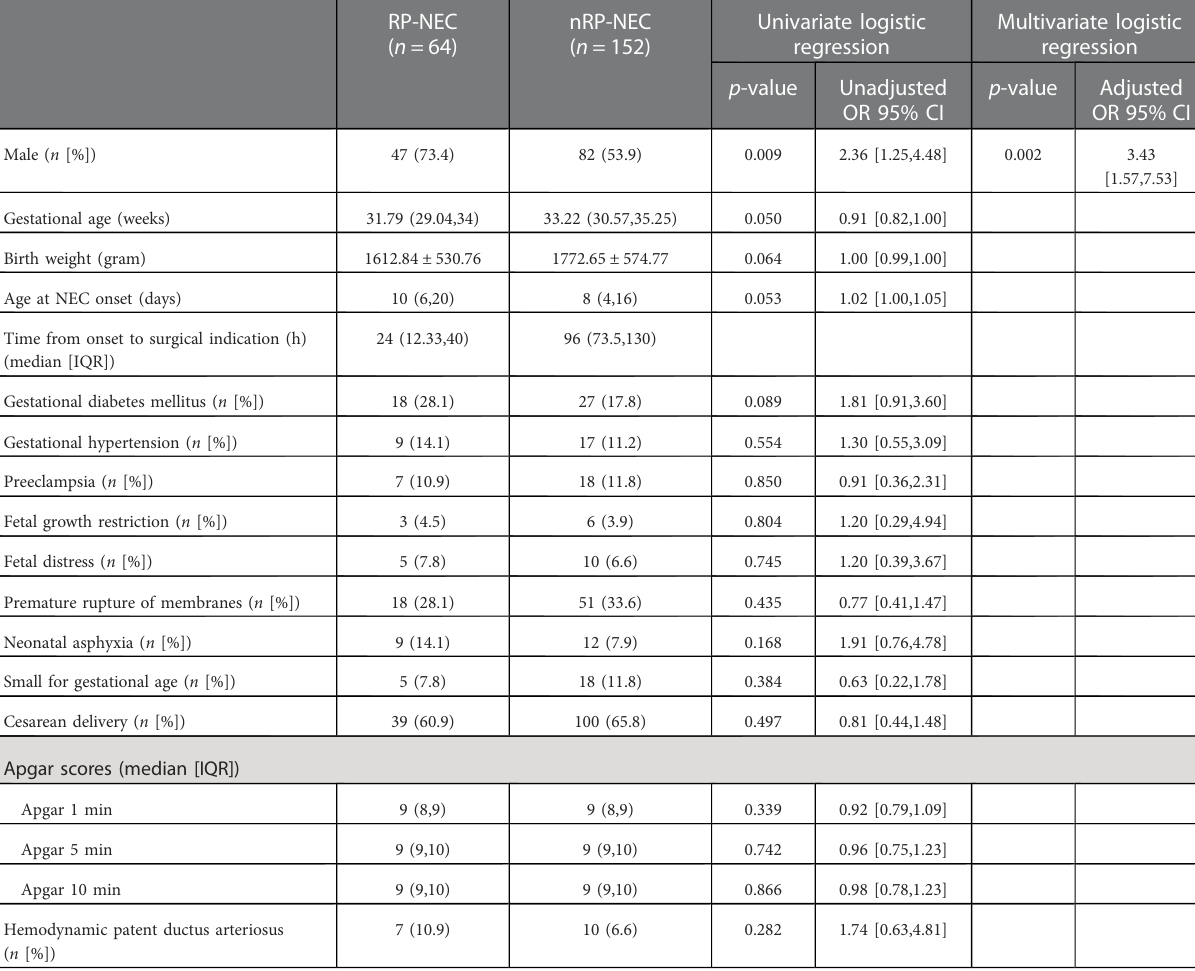
TABLE 1 Univariate and multivariate logistic regression analyses for determining the demographic features of RP- and nRP-NEC.